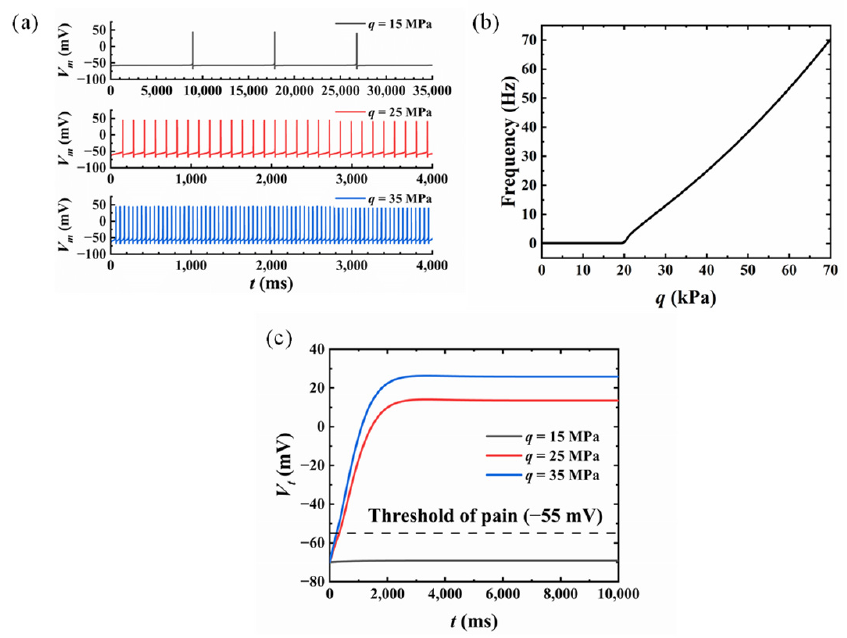
Figure 6. Skin pain sensation with different compression amplitude values: ( a ) membrane potential variation; ( b ) the relationship between compression amplitude and frequency; ( c ) the variation of T-cell output.